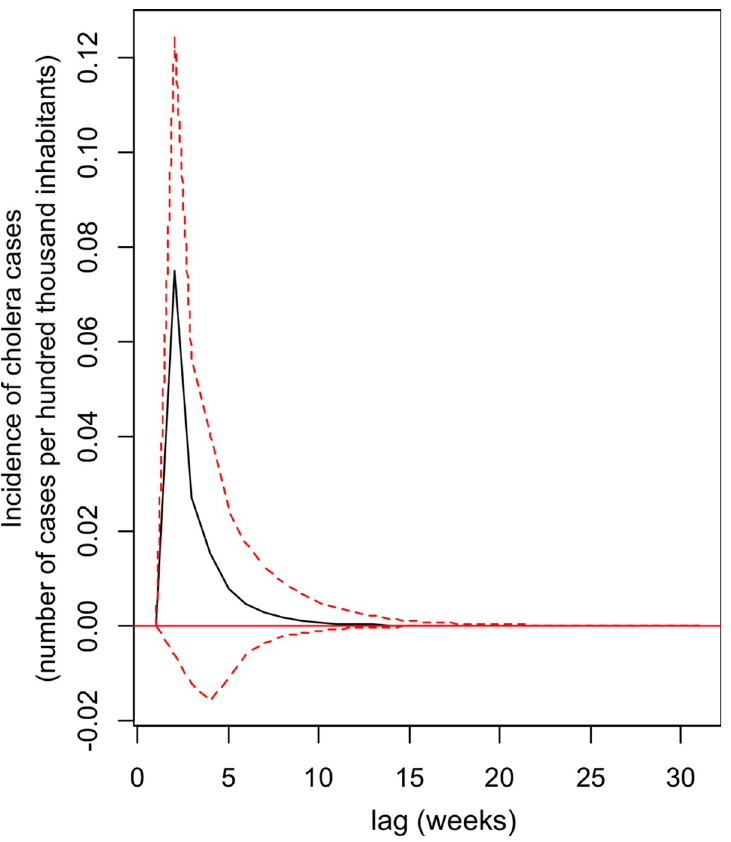
Fig 4. Impulse Response Function (IRF) showing the impact of an increase in volcanic activity (through the flow of volcanic sulphur dioxide) on the incidence of cholera cases in the population of the Katana Health Zone, DR Congo, over a 15-week period. The largest positive effect is observed about three weeks after the shock due to volcanic activity and the return to equilibrium is only observed around the 15th week. Black line: Impulse Response Function, dotted lines: 95% confidence level curves (obtained through 100 runs of the bootstrap method).